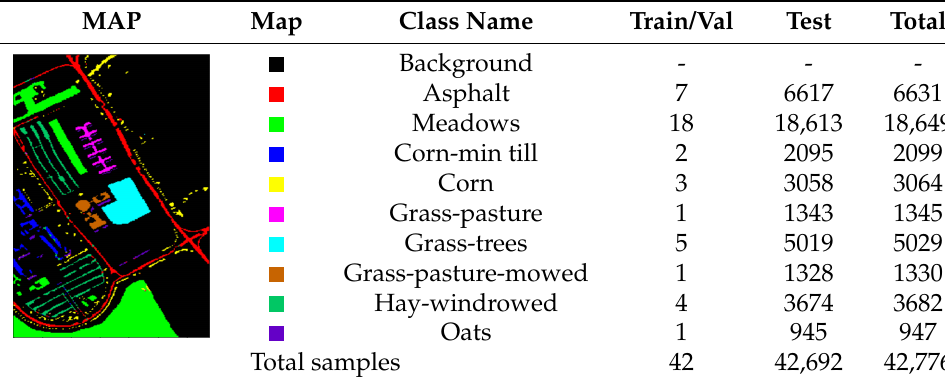
Table 3. Sample labels and sample size for the University of Pavia dataset.